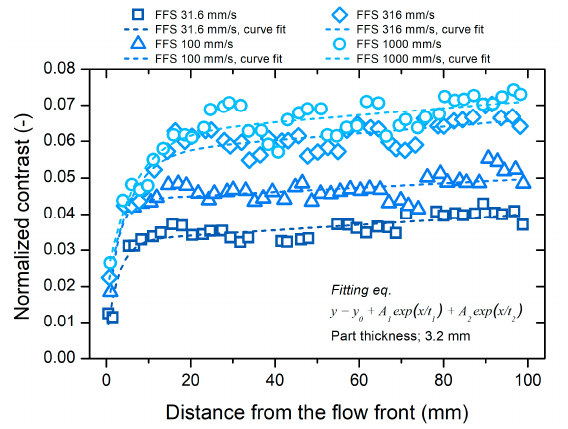
Figure 9. Contrast distribution of the short-shot specimen.